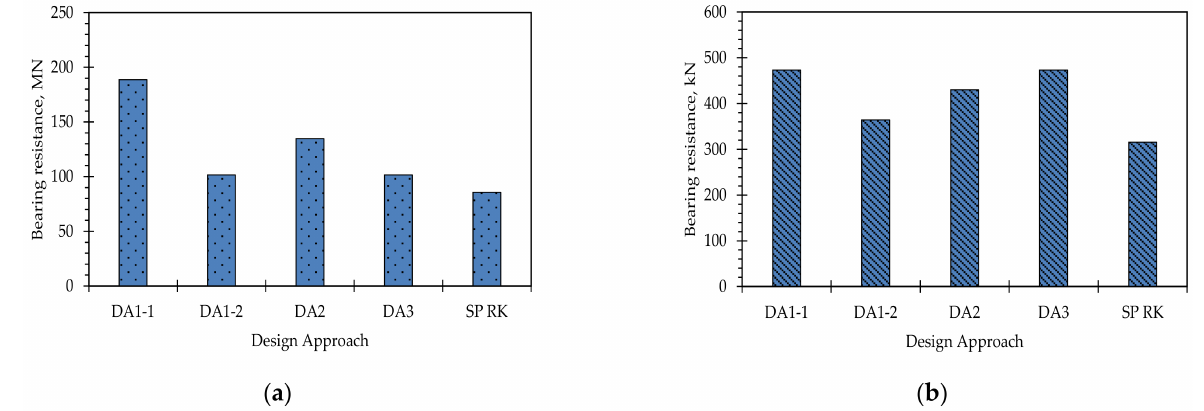
Figure 5. Bearing resistance values of the ( a ) raft foundation and ( b ) pile foundation.